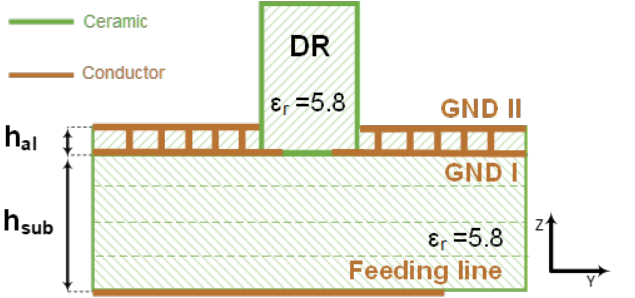
Figure 8. Schematic of the proposed stack with grounded and grooved superstrate for the CDRA. Figure 7. Comparison of the simulated gain profile for the single element CDRA for conventional, grooved superstrate and the grounded grooved superstrate stack.